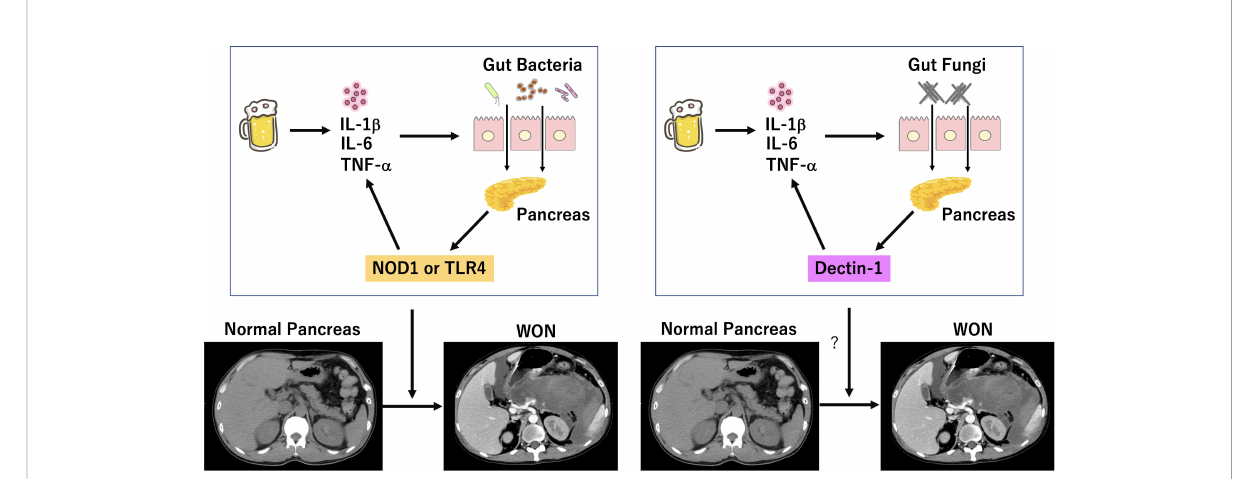
FIGURE 1 Involvement of bacterial and fungal infection in the development of severe acute pancreatitis. Excessive drinking of alcohol induces auto- digestion of pancreatic tissues due to intrapancreatic activation of trypsinogen. Pro-in fl ammatory cytokine responses induced by initial in fl ammation dampen intestinal barrier function and allow entry of gut bacteria into the pancreas. Sensing of bacteria by nucleotide-binding oligomerization domain 1 (NOD1) and toll-like receptor 4 (TLR4) leads to a robust production of pro-in fl ammatory cytokines, which in turn